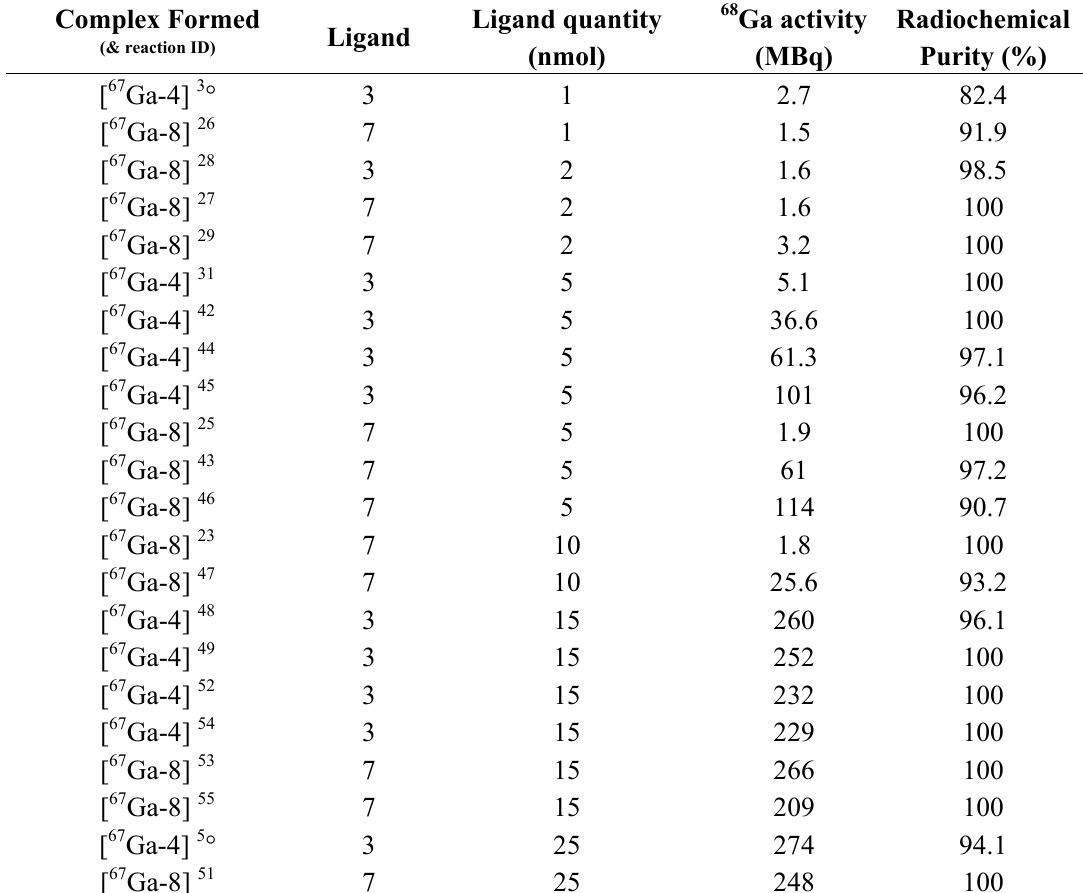
Table 1. 67 Ga Radiolabelling